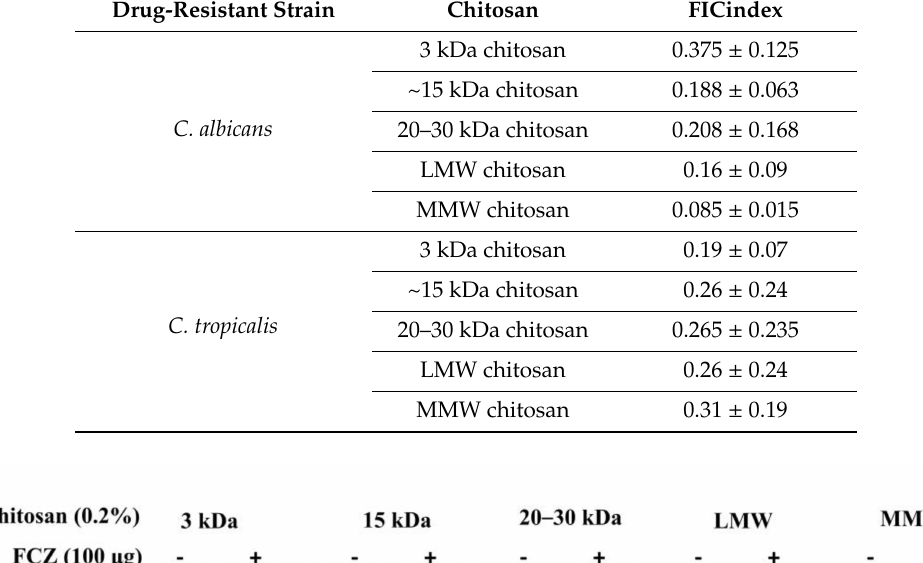
Table 5. Checkerboard assays of each chitosan in combination with fluconazole against fluconazole-resistant clinical strains.